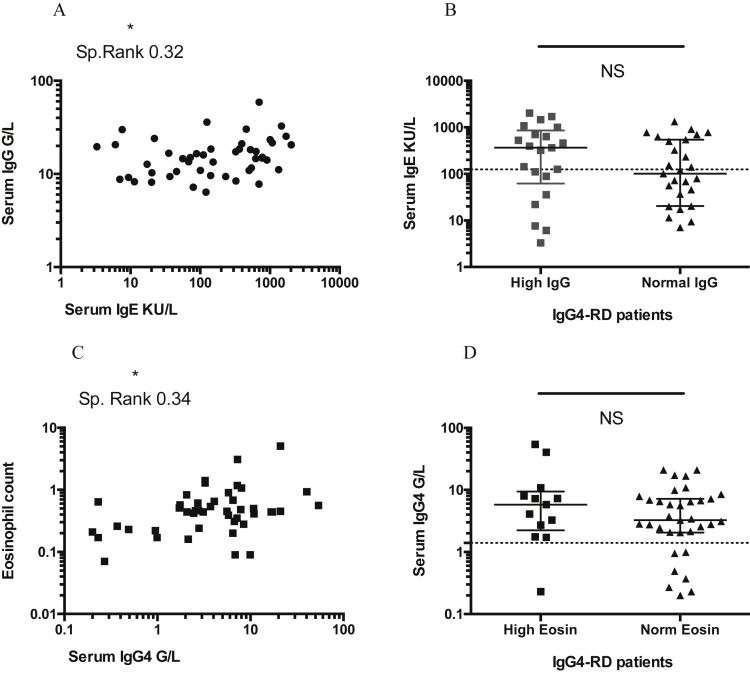
The relationship of serum IgE with serum IgG, and serum IgG4 with peripheral blood eosinophil count, in IgG4-RD. (A) Correlation plots showing serum IgE (kIU/L) concentration plotted against serum IgG (g/L) concentrations in IgG4-RD. (B) Dot plots of serum IgE concentrations in IgG4-RD patients with a high (≥16.0 g/L) or normal serum IgG. Dashed line is the serum IgE upper limit of normal (≥125 kIU/L). (C) Correlation plots showing blood eosinophil count (cells/μL) plotted against serum IgG4 (g/L) concentrations in IgG4-RD. (D) Dot plots of serum IgG4 concentrations in IgG4-RD patients with a high (≥500 cells/μL) or normal eosinophil count. Dashed line is the serum IgE upper limit of normal (≥125 kIU/L). Spearman rank correlation coefficient and P values are expressed as NS ≥0.05, *P < .05, Mann-Whitney P values, where NS P ≥ .05, *P < .05. Sp., Spearman.